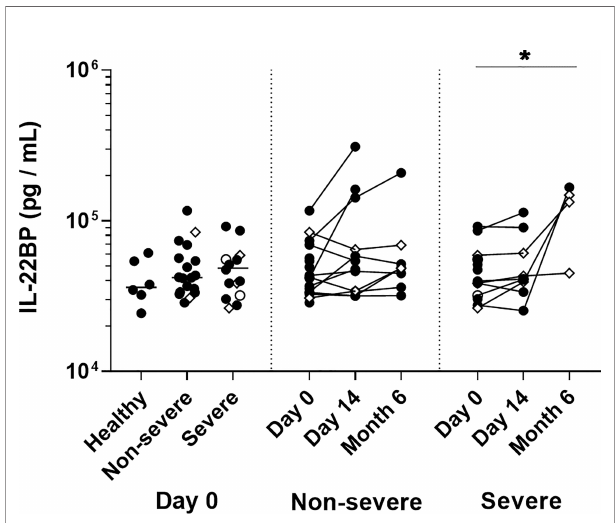
FIGURE 9 | Plasma IL-22 binding protein levels in COVID-19 patients. IL- 22BP levels measured on the day of admission are represented on the left panel for healthy controls (n=6), non-severe (n=18) and severe (n=14) COVID- 19 patients. The horizontal bars indicate the medians of the results within each column at D0. Kinetic analysis of IL-22BP levels over time is represented for 11 non-severe and nine severe COVID-19 patients at D0 and D14, and for eight non-severe and four severe patients six months after their inclusion The patients who died from COVID-19 are represented as an empty circle, and the patients who declared long-term COVID-19 at their 6 months follow-up (2 out of 8 non-severe and 3 out of 4 severe cases) are represented on the graphs as empty diamonds. The signi fi cant p values < 0.05 is represented on the graph as *, obtained both by Kruskal Wallis test and Friedman U